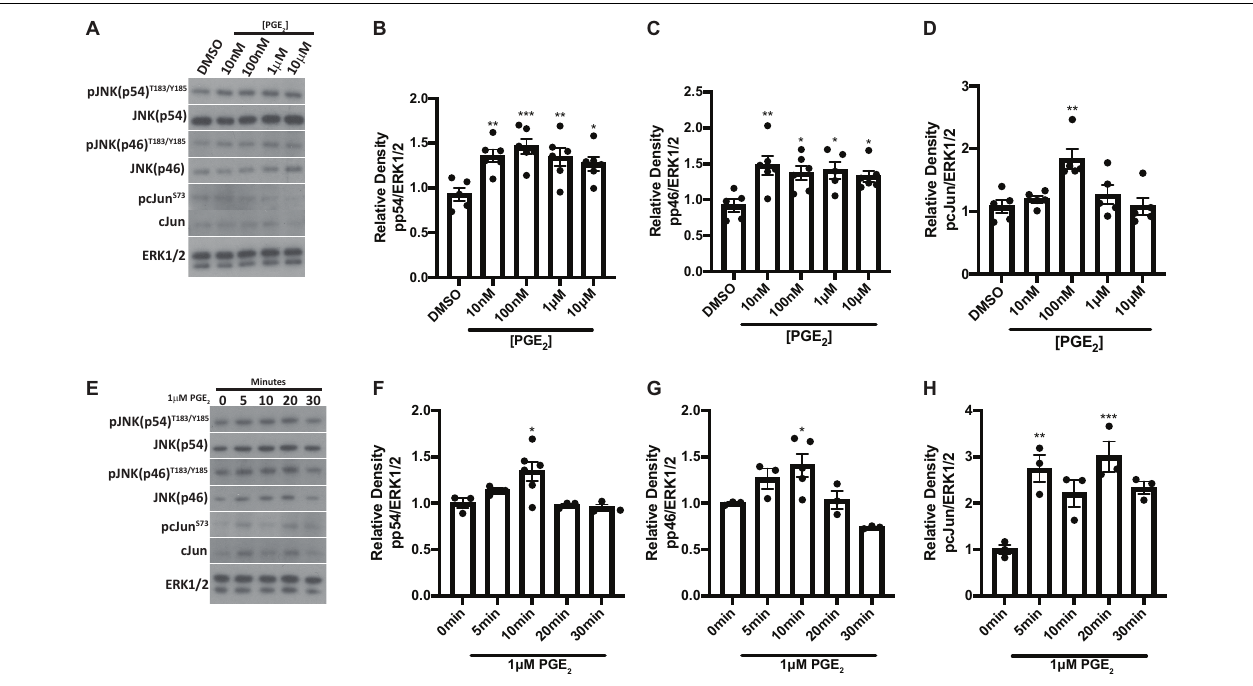
FIGURE 3 | PGE 2 treatment activates JNK pathways in primary parotid acinar cells. Primary parotid acinar cells were prepared from C57BL/6J mice as described in section “Materials and Methods.” (A–D) Dispersed parotid cell aggregates were treated with vehicle (DMSO) or varying doses of PGE 2 (10 nM, 100 nM, 1 or 10 µ M) in serum-free media for 10 min. (A) Representative Western blot images of phosphorylated JNK signaling molecules following PGE 2 treatment at the indicated concentrations. (B–D) Densitometry of Western blots represented in panel (A) . (E–H) Dispersed parotid cell aggregates were treated with vehicle (DMSO) or 1 µ M PGE 2 in serum-free media for 5, 10, 20, or 30 min. (E) Representative Western blot images of the kinetics of PGE 2 -mediated phosphorylation of JNK signaling molecules following 1 µ M PGE 2 treatment. (F–H) Densitometry of Western blots represented in panel (E) . (A–H) Immunoblots were generated from cell lysates using anti-phospho-JNK/SAPK (p54/p46) T183 / Y185 or anti-phospho-c-Jun S73 antibodies, which were stripped and re-probed for JNK/SAPK (p54/p46) or c-Jun and then ERK1/2 as a loading control. Densitometry was performed using ImageJ software and protein content was normalized to the average of DMSO-treated cells (A–D)